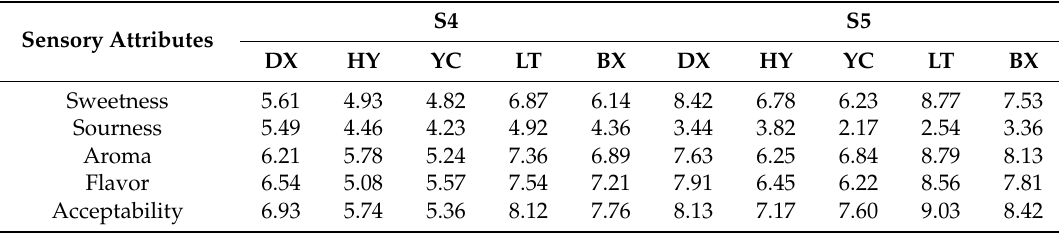
Table 3. Global acceptability and sensory attributes of apricot fruit of stage 4 (S4) and stage 5 (S5).